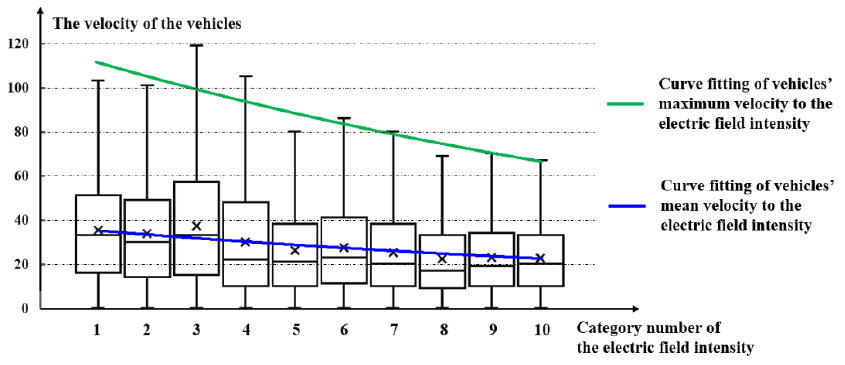
Figure 12. Correlation between the maximum velocity/mean velocity of the vehicles and